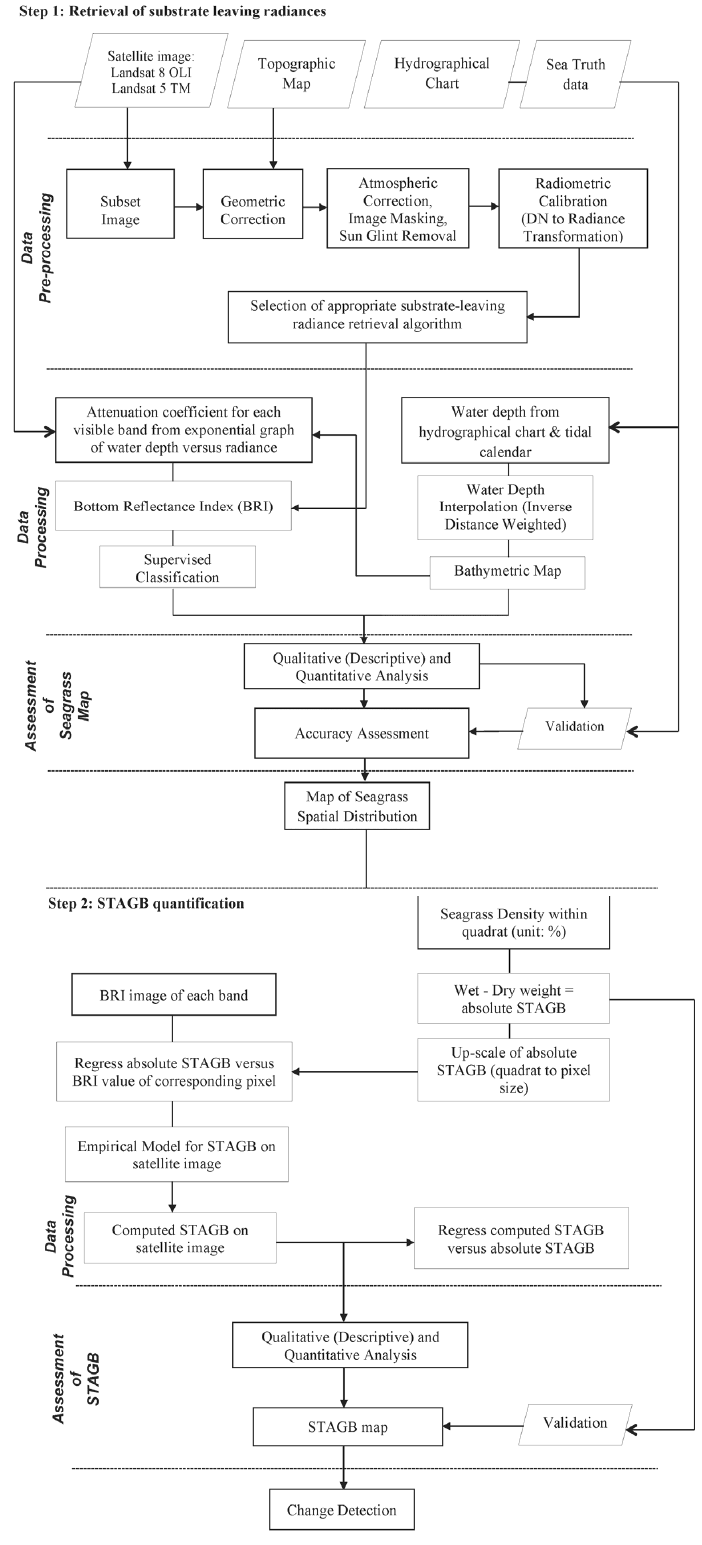
Figure 3. Submerged STAGB quantification flowchart using BRI.